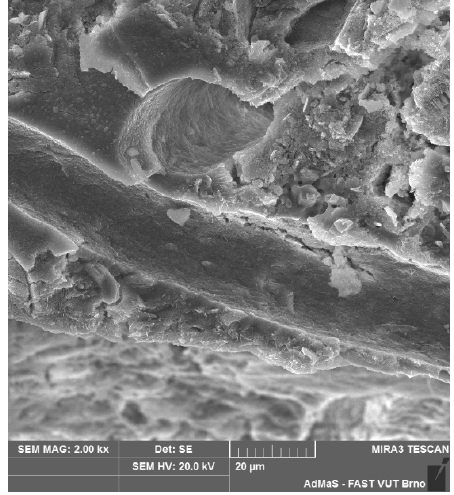
Figure 12. REC 3–1000 °C (500×).